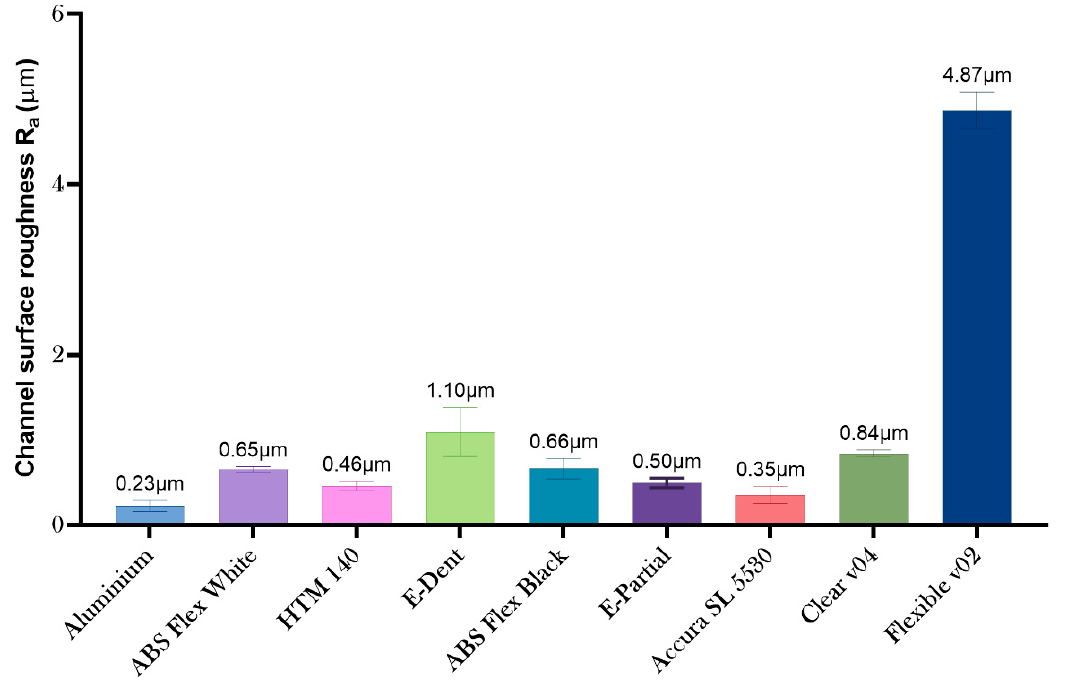
Figure 6. Mean surface roughness of assessed materials.